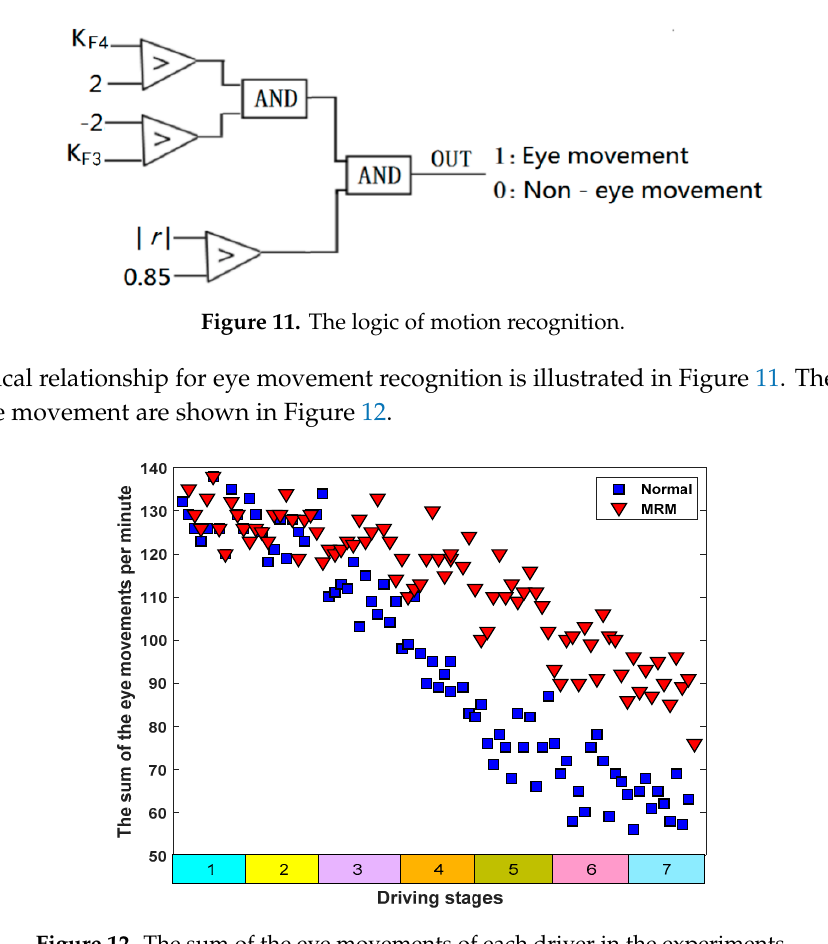
Figure 10. Eye movement signals.